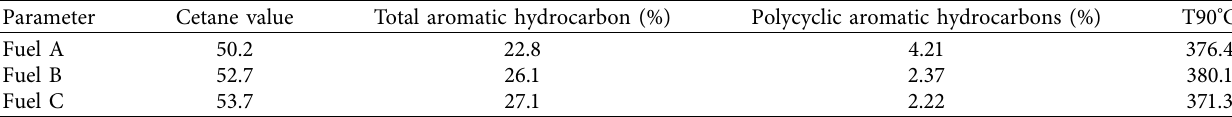
Table 1: Summary of the test results for the three fuels.